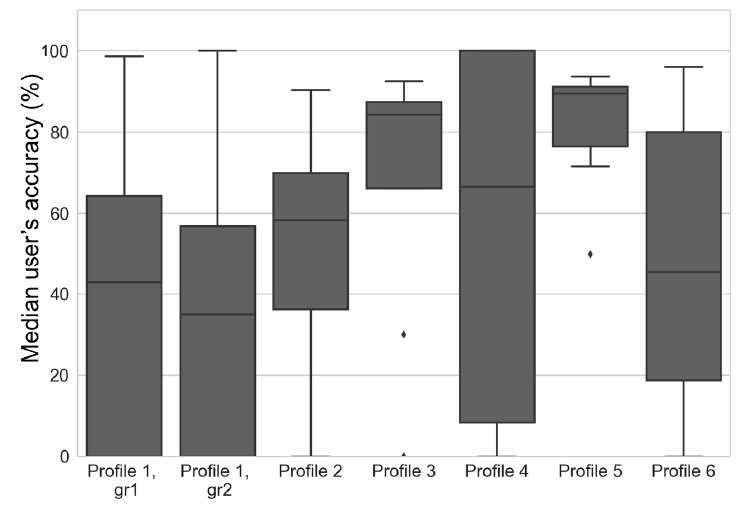
Figure 15. Boxplot showing median values of users’ accuracies by user profile.